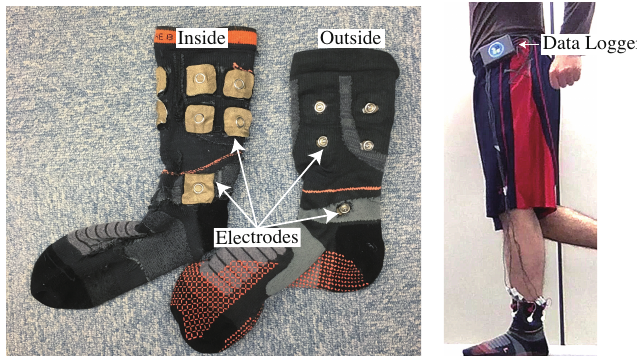
Figure 5. ( Left ): configuration of sock-type wearable sensor for estimating lower leg muscle activity with 10 conductive-fabric electrodes around the ankle to measure five channels; a conductive-fabric electrode placed on medial malleolus, acting as the ground. ( Right ): patient wearing socks; each side of the sock estimates activity of each lower leg muscle and each snap is connected to the data logger via